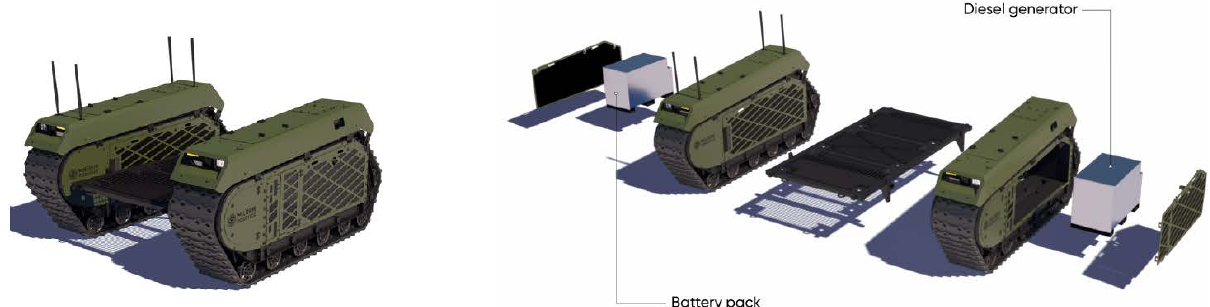
Figure 2. The Multiscope unmanned ground vehicle